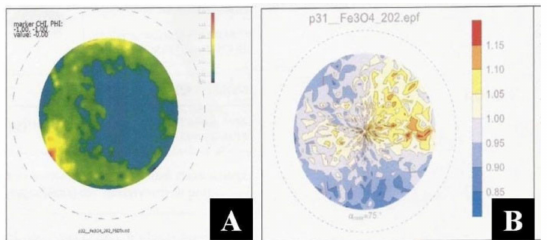
Figure 7. Corrected, incomplete polar figure obtained for the Fe 3 O 4 phase, for [epoxy resin (Epidian 5) and magnetite (Fe 3 O 4 )] composite without the application of CMF ( A ) and in CMF of B = 0.5 T ( B